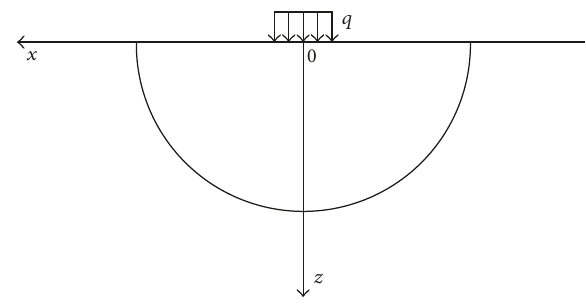
Figure 1: Water infiltration into a semi-infinite unsaturated porous